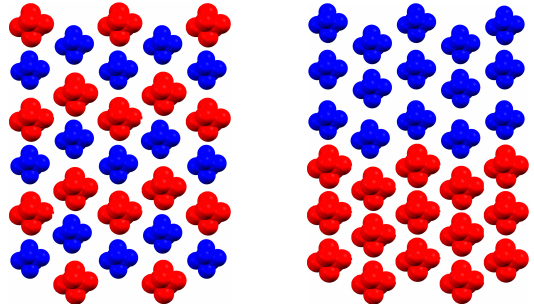
Figure 2. Two schematic depictions of a sheet parallel to the b–c plane of [Fe(phen) 2 (NCS) 2 ], filled with high spin (HS) and low spin (LS) molecules (coloured in red and blue, respectively). Both configurations yield γ HS = 0.5. The left configuration ( c (cid:96) ) corresponds to the unit cell configuration 6 in Table 1, while the right configuration ( c r ) cannot be understood as a periodic continuation of a unit cell